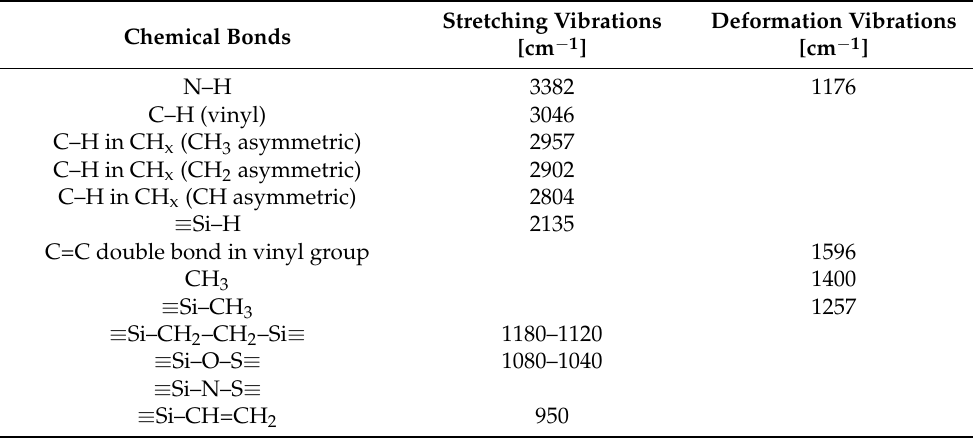
Table A2. Overview of FTIR stretching and deformation vibrations in Durazane 1800